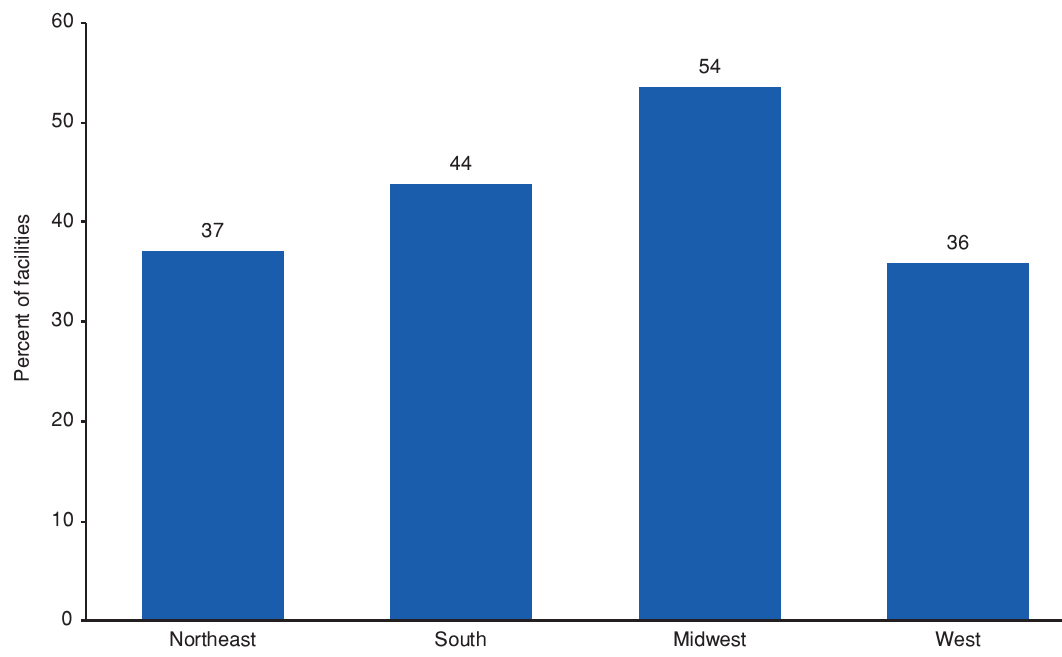
Figure 11. Mental health treatment facilities accepting clients of all ages for treatment, by region: